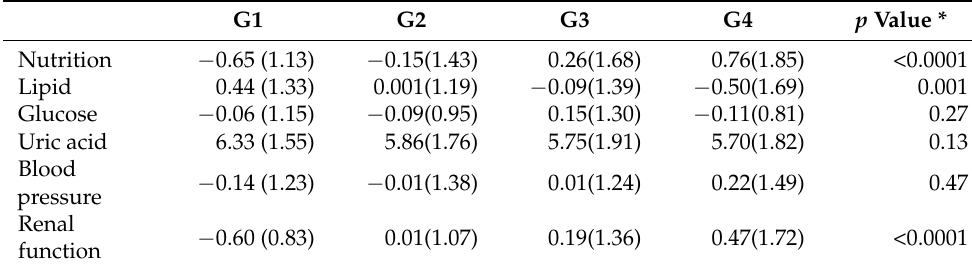
Table 5. Mean and SD of six risk variables by Four Groups.